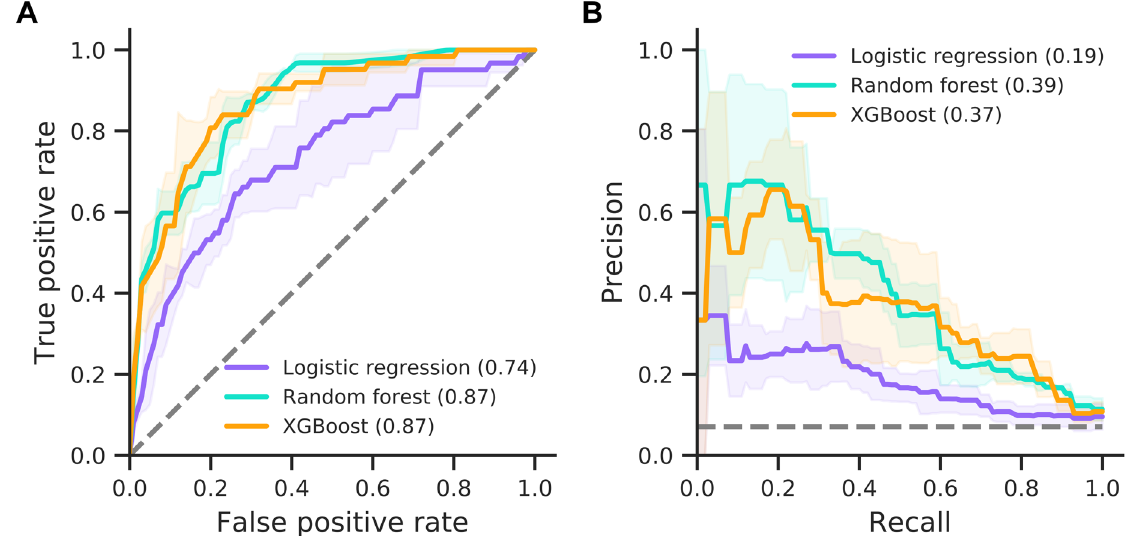
Figure 4. Prediction performance for mechanical ventilation. Model performances for the logistic regression, random forest and XGBoost models are shown as ROC ( A ) and precision-recall curves ( B ). AUC is provided in brackets. Solid lines and shaded areas indicate the mean and standard deviation across three cross-validation folds, respectively. Dashed lines indicate random